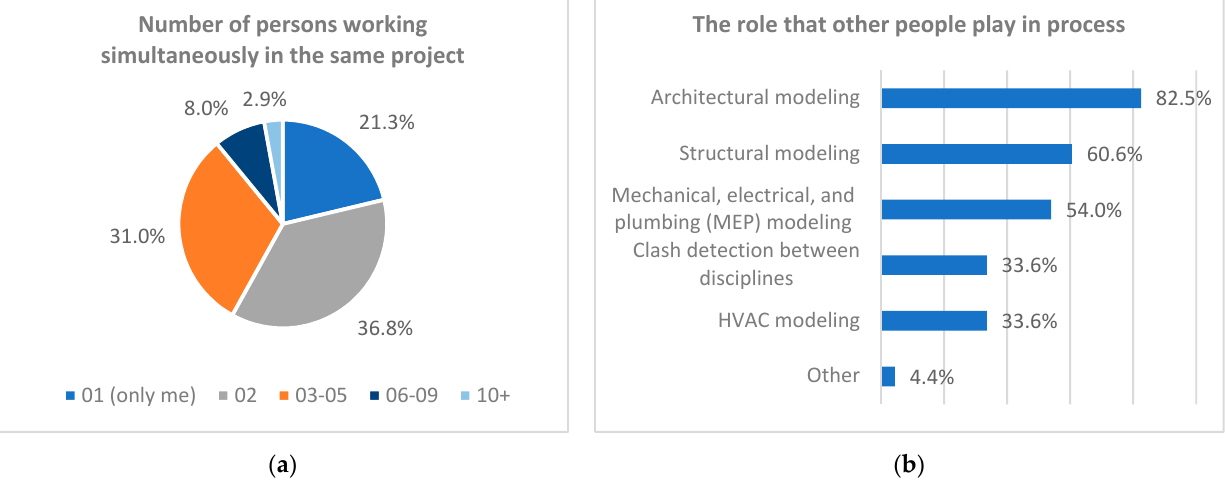
Figure 17. Collaborative work charts. ( a ) Chart showing the number of persons working simultaneously in the same project, ( b ) The role that other people play in the scan-to-BIM process.